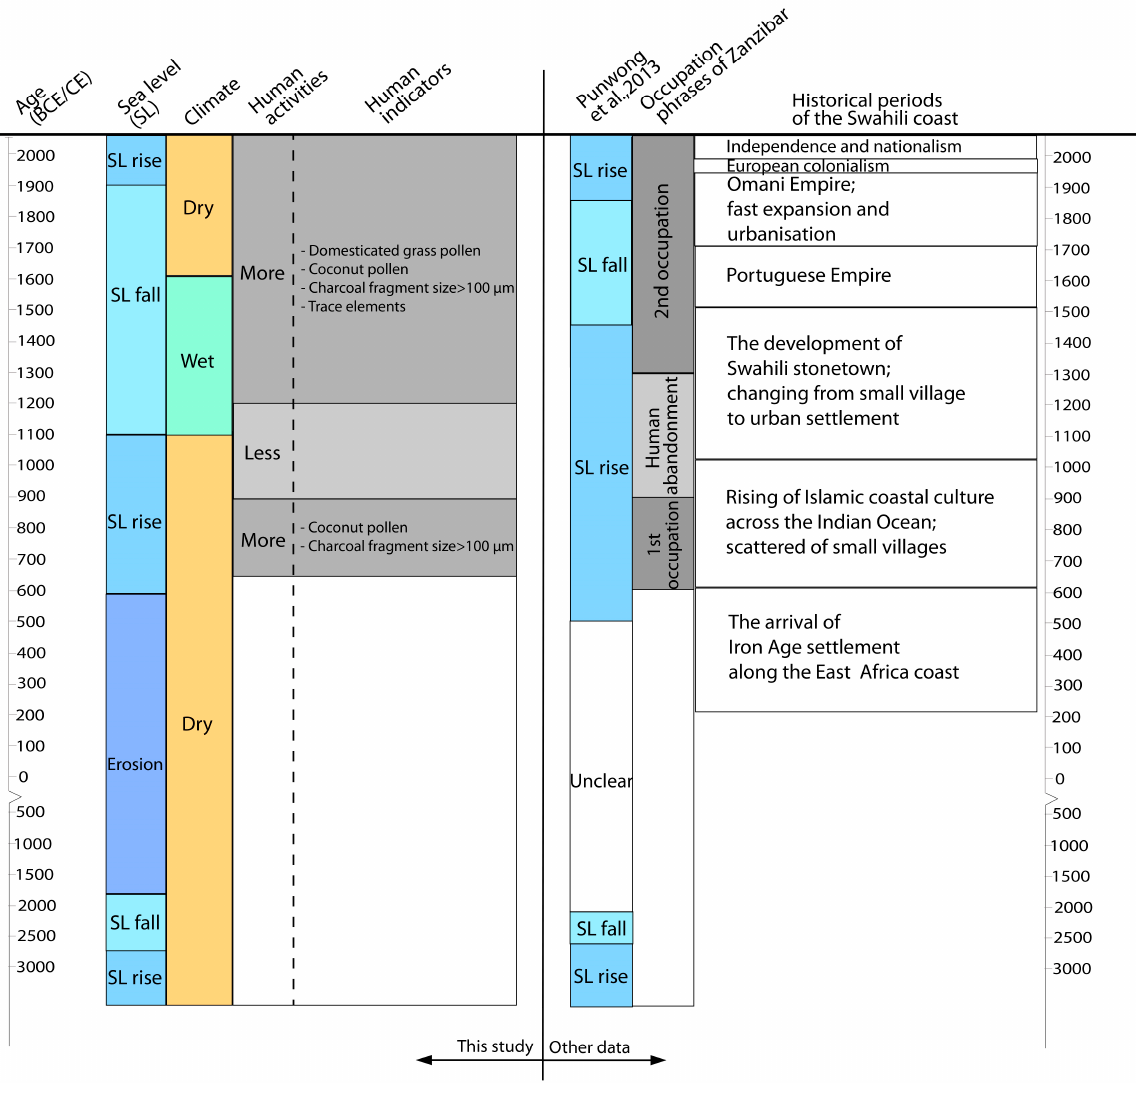
Figure 11. Summary diagram showing the main findings of this study coupled with previous study [9] and historical periods referring to the timing of human activities in Unguja Ukuu, Zanzibar Is- land.